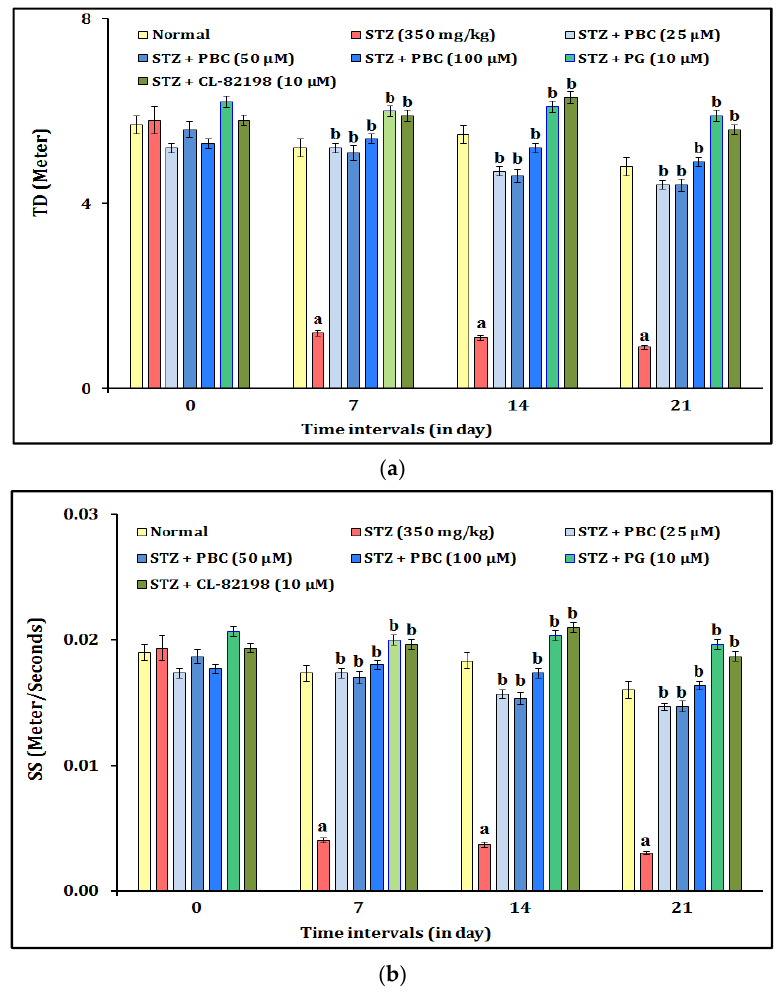
Figure 3. ( a ) Effect of PBC in DNP-induced TD changes in mechanical pain sensation. Data are expressed as mean ± SD, n = 20 zebrafish per group. Abbreviation: CL-82198, MMP-13 inhibitor; PG, pregabalin; SS, swimming speed; STZ, streptozotocin; TD, travel distance. ( b ) Effect of PBC in DNP-induced changes in mechanical pain sensation. Data are expressed as mean ± SD, n = 20 zebrafish per group. Abbreviation: CL-82198, MMP-13 inhibitor; PG, pregabalin; SS, swimming speed; STZ, streptozotocin; SS, swimming speed. a p < 0.05 vs. normal group. b p < 0.05 vs. STZ control group.